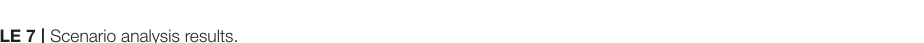
TABLE 7 | Scenario analysis